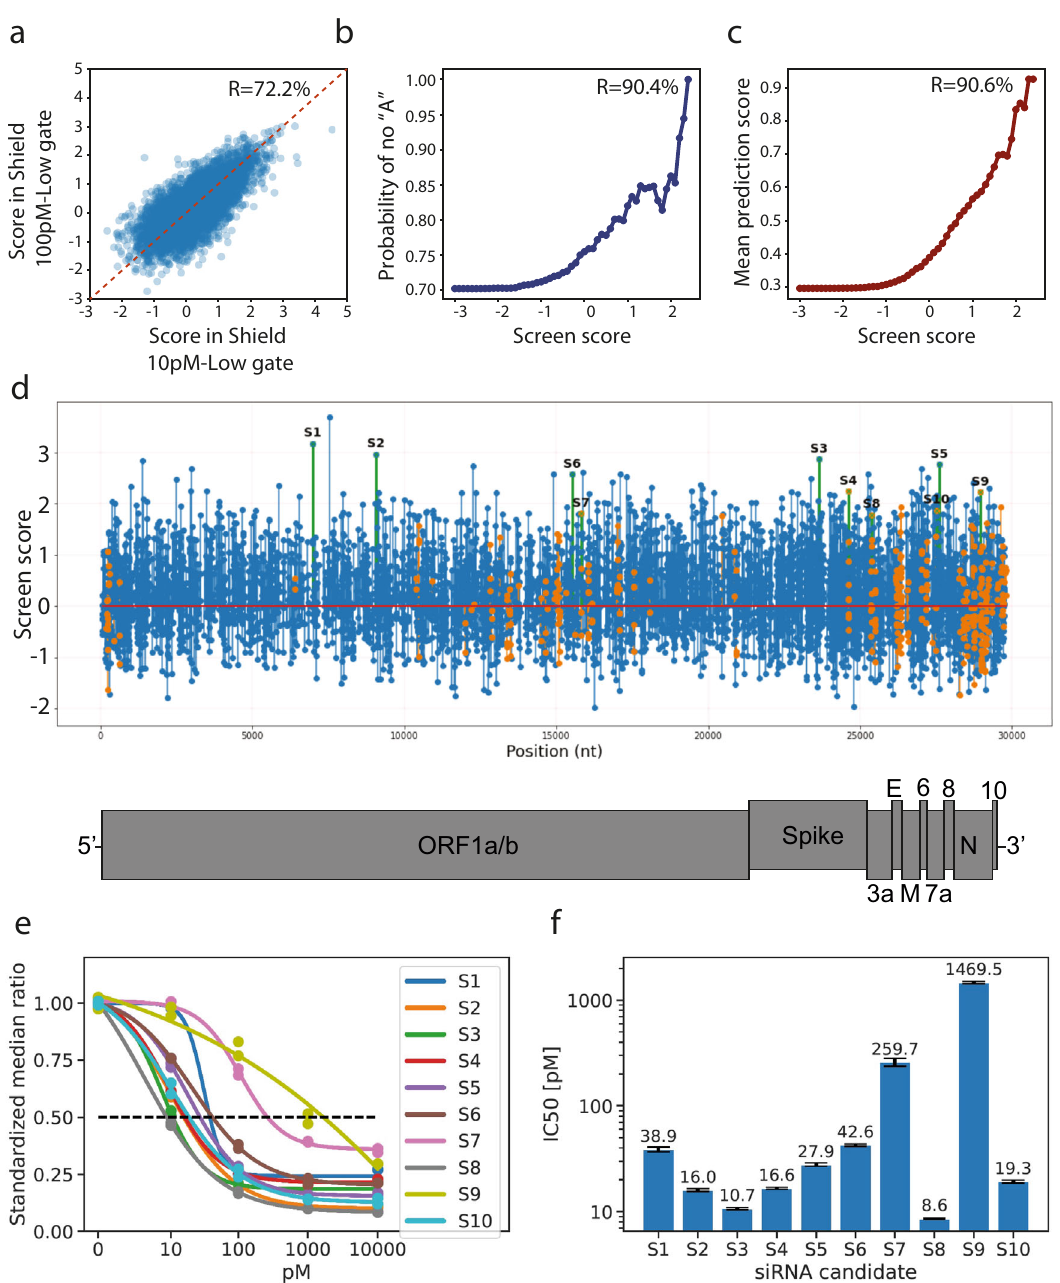
Fig. 2 Validation of screen results for n = 17,589 shRNAs. a Screen scores had a high internal consistency. The screen results showed a Pearson correlation of 72.2% between the scores in the two top-performing conditions; b Enrichment of features associated with potent shRNAs. The probability of not fi nding an adenine in position 20 of RNAi triggers targeting SARS-CoV-2 increased with screen scores, recapitulating previous studies indicating that when adenine occupies position 20 it weakens shRNA maturation; c Screen scores highly correlated with bioinformatic predictions. The screen scores, representing enrichment statistics as calculated by DESeq2, were highly correlated with a published machine learning algorithm predicting the potency of shRNAs; d Screen results and the selected candidates. The graph shows the resultant screen scores of each RNAi trigger that passed the quality threshold, as a function of position along the viral genome. Orange: RNAi triggers that targeted conserved regions between SARS-CoV and SARS-COV-2. Green: The selected ten candidates. Blue: all other RNAi riggers; e Dose-response curves of the selected ten candidates. siRNAs were tested using a reporter assay. The plot represents the standardised median ratio between the expression of mCherry (reporter gene) and GFP (control gene); f Potency scores of each of the 10 selected candidates. The IC 50 value of each of the 10 candidates was calculated based on the dose-response curves in ( e ). Standard errors for IC50 computations were computed using statistical bootstrap over all data points at each concentration